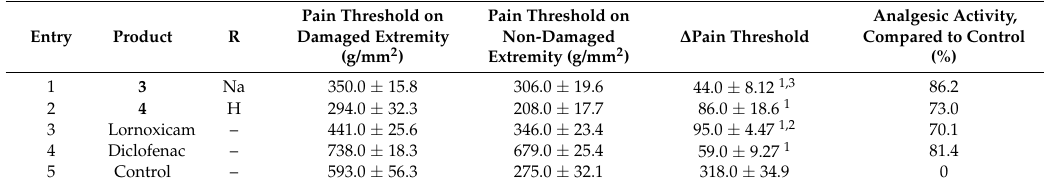
Table 2. The Analgesic Activity of Sodium Salt 3 , Acid 4 , and Reference Drugs.